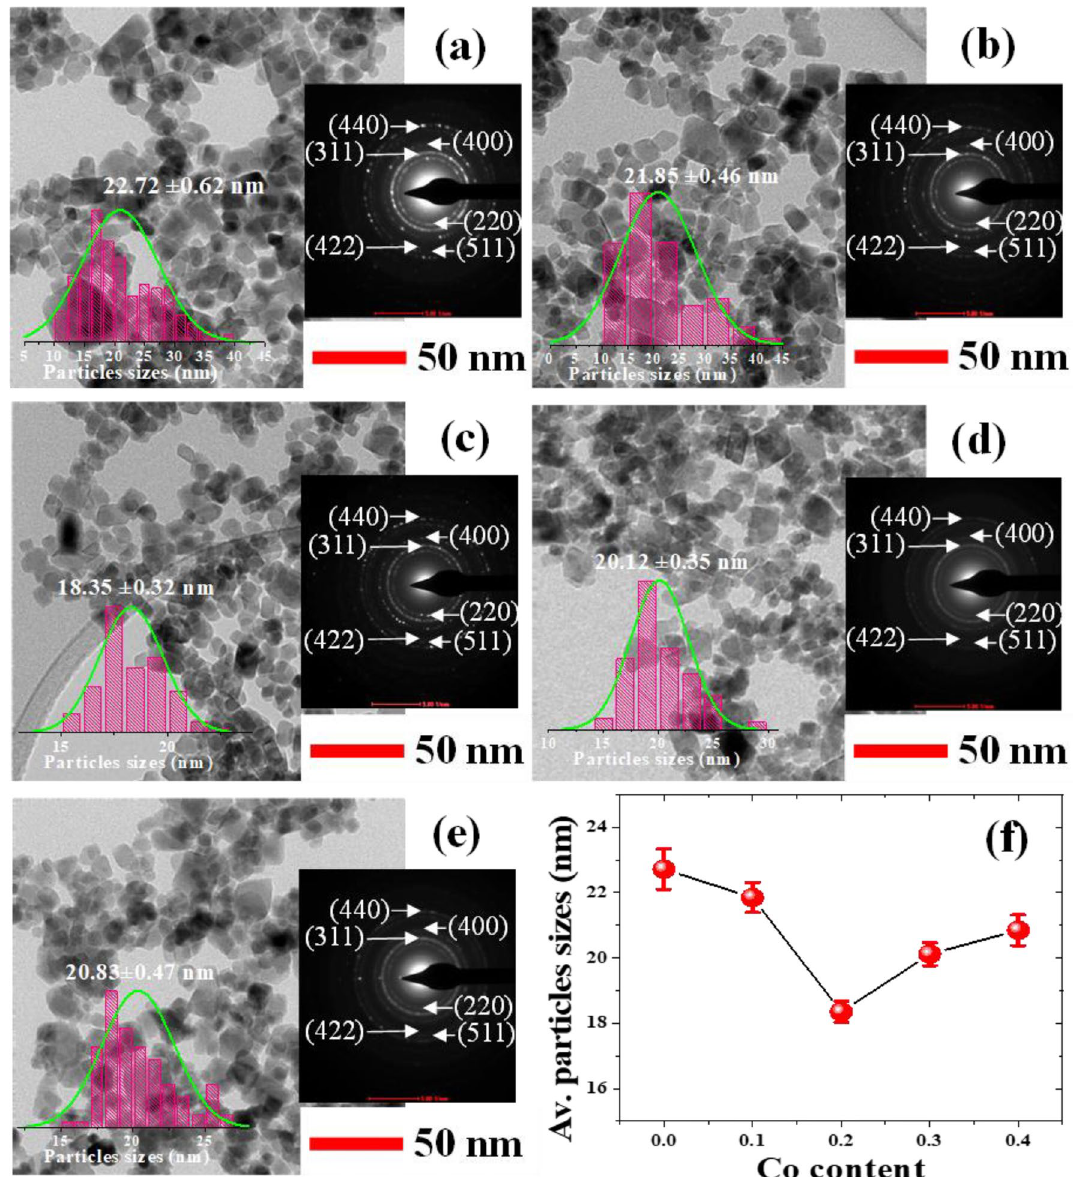
Figure 6. TEM images with SAED patterns and histograms showing the particle size distribution of